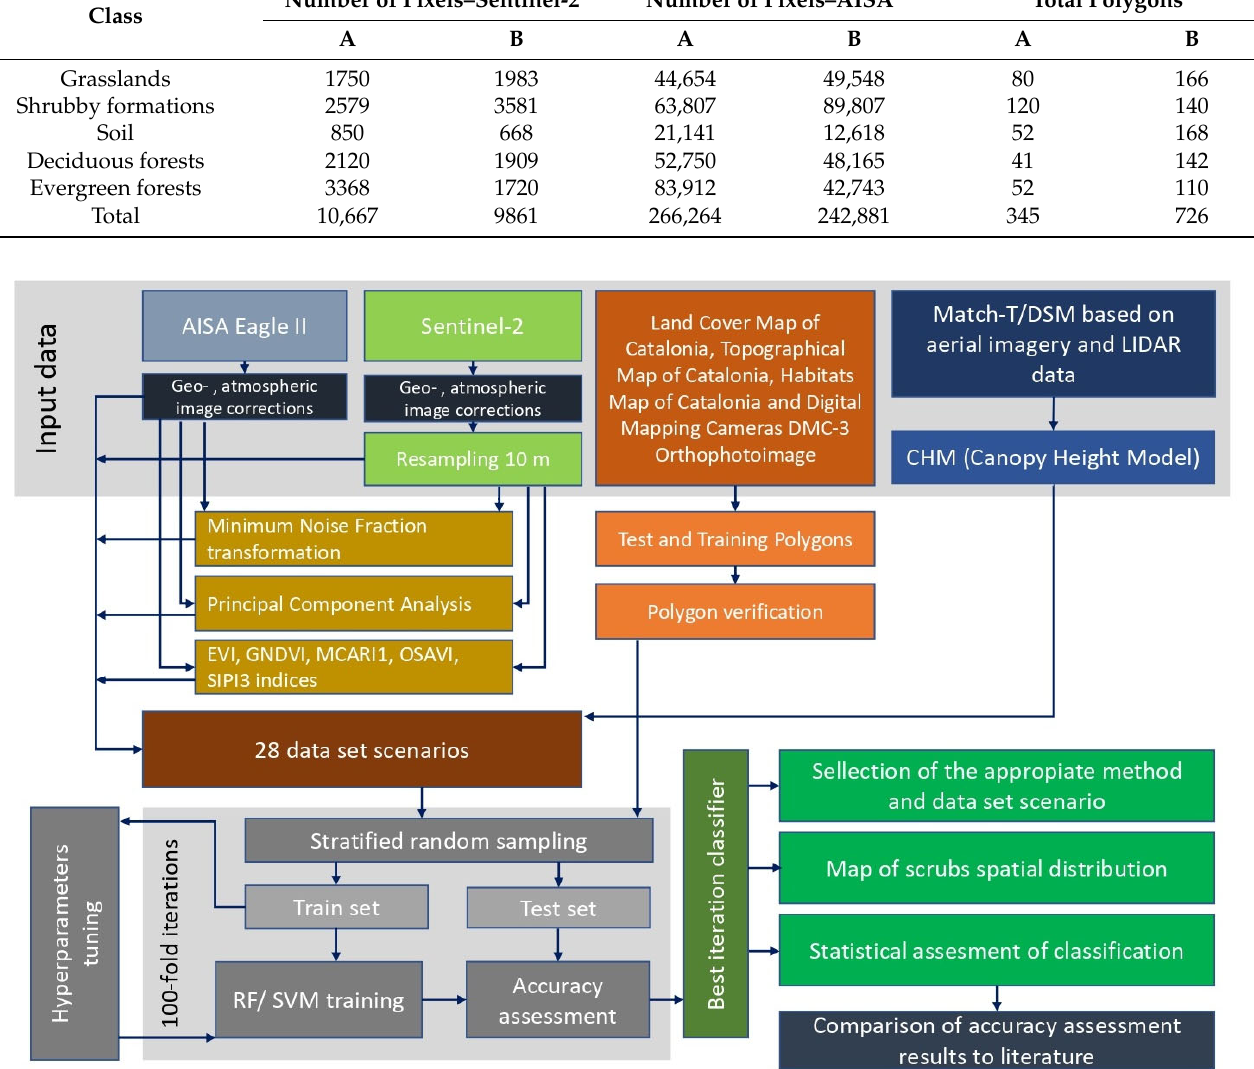
Figure 3. Analysis flow chart of multispectral and hyperspectral classifications.